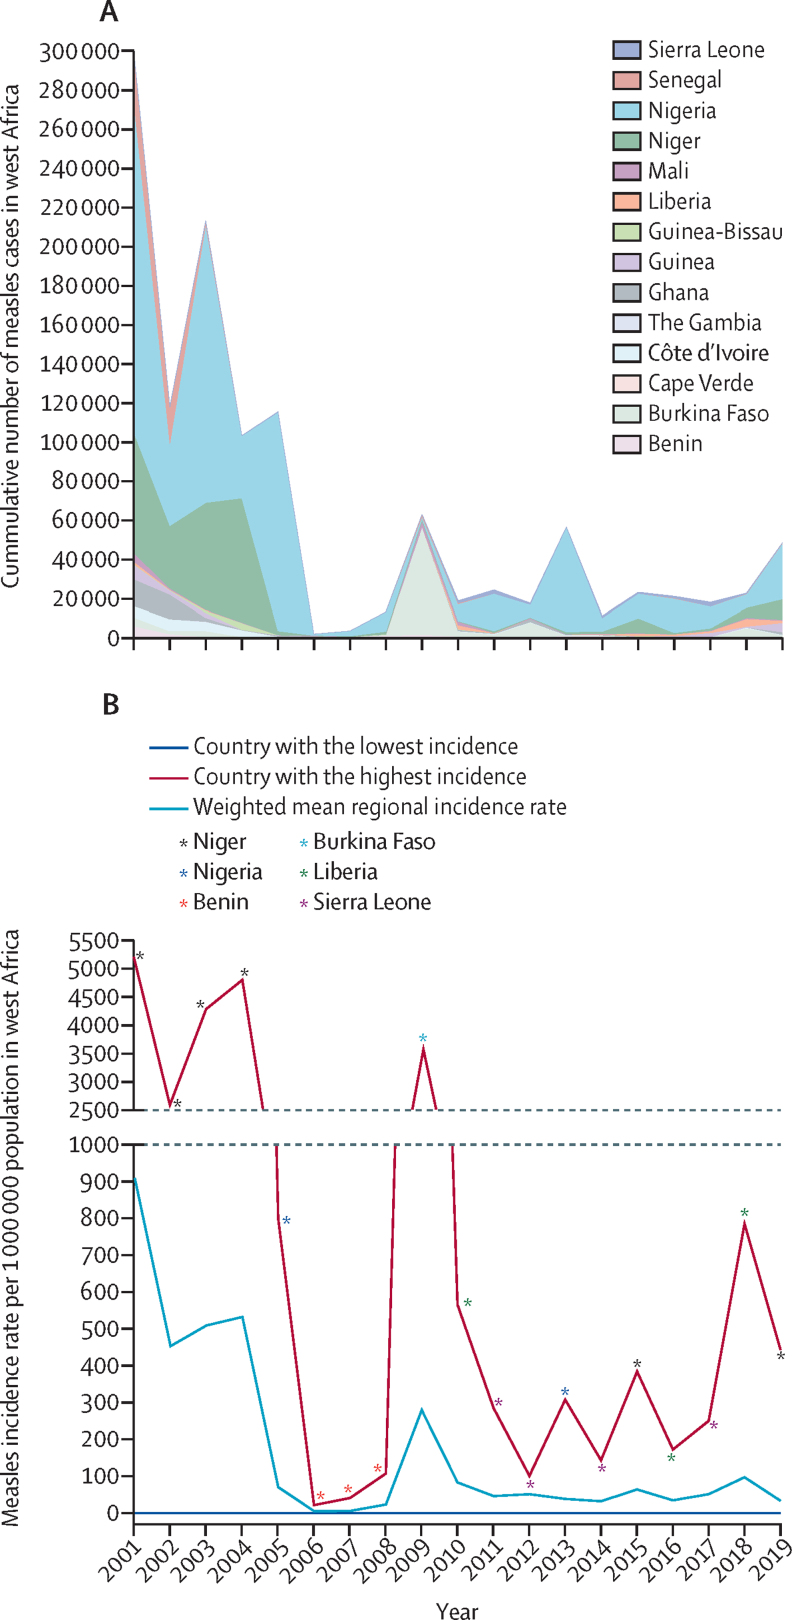
Measles cases and measles incidence rate per million population in west Africa, 2001–19(A) Cumulative number of reported measles cases per year. The number of measles cases for Togo during this period were quite small compared with other countries, thus, they are not visible in this figure. (B) Measles incidence rate per million population between 2001 and 2019 based on available country-level cases reported to WHO in 15 west African countries. Cape Verde consistently reported the lowest measles incidence rate of zero per million population. Country-level population was based on the UN World Population Prospects 2019.